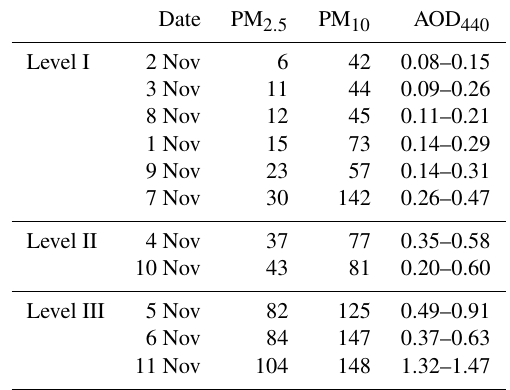
Table 4. Classification of case days based on daily average PM 2 . 5 and PM 10 concentrations and the variation range of AOD 440